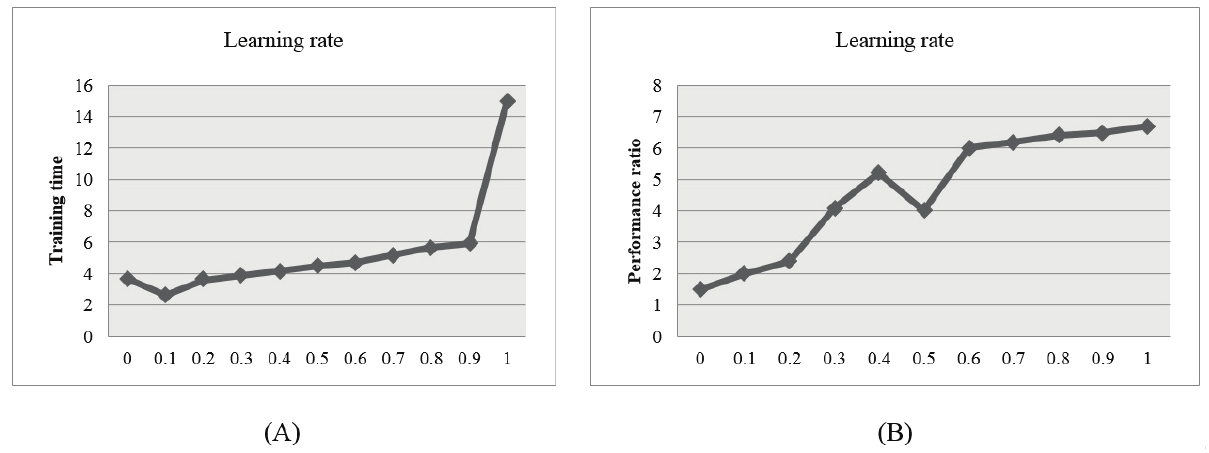
Figure 5: (A) learning rate vs. training time, (B) learning rate vs. performance